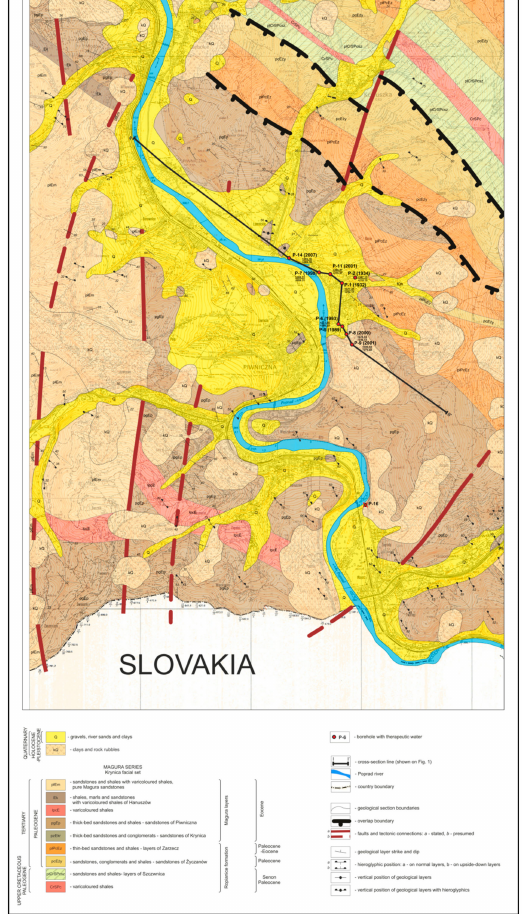
Figure 3. Geological map of analyzed area [32,34]